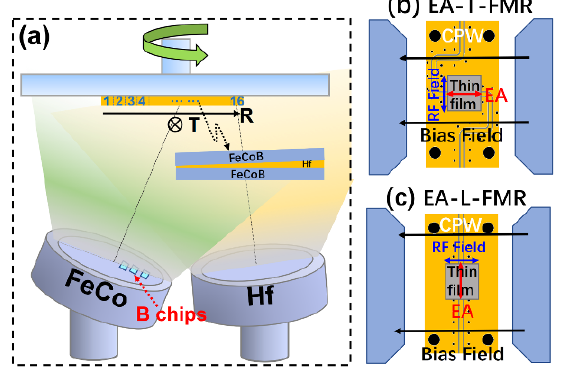
Figure 1. ( a ) Schematics of the MCGS device and the profiles of the film, fixture, and magnetic field for the EA-T-FMR ( b ) and the EA-L-FMR ( c ). The inset in ( a ) shows the structure of the FeCoB/Hf/FeCoB trilayer.